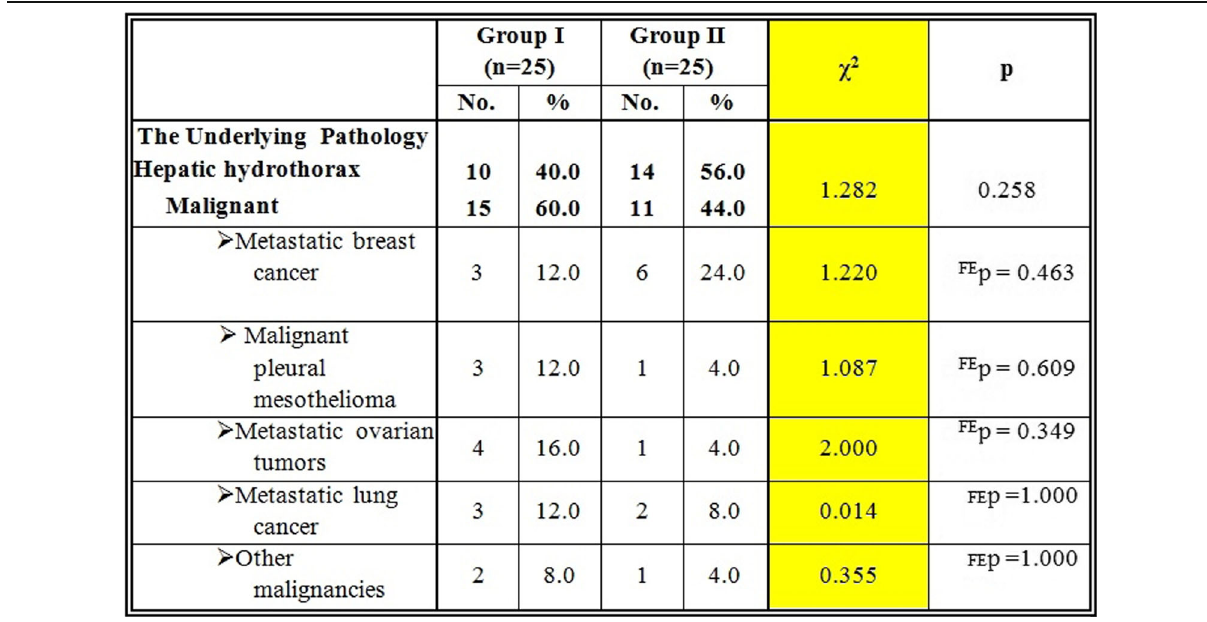
Table 4 Comparison between the studied groups as regard the underlying